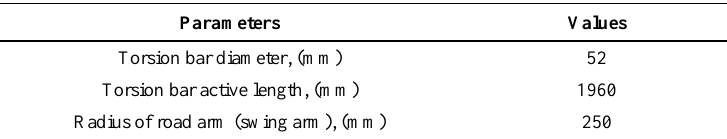
Table 4. Specifications of torsion bar suspension.